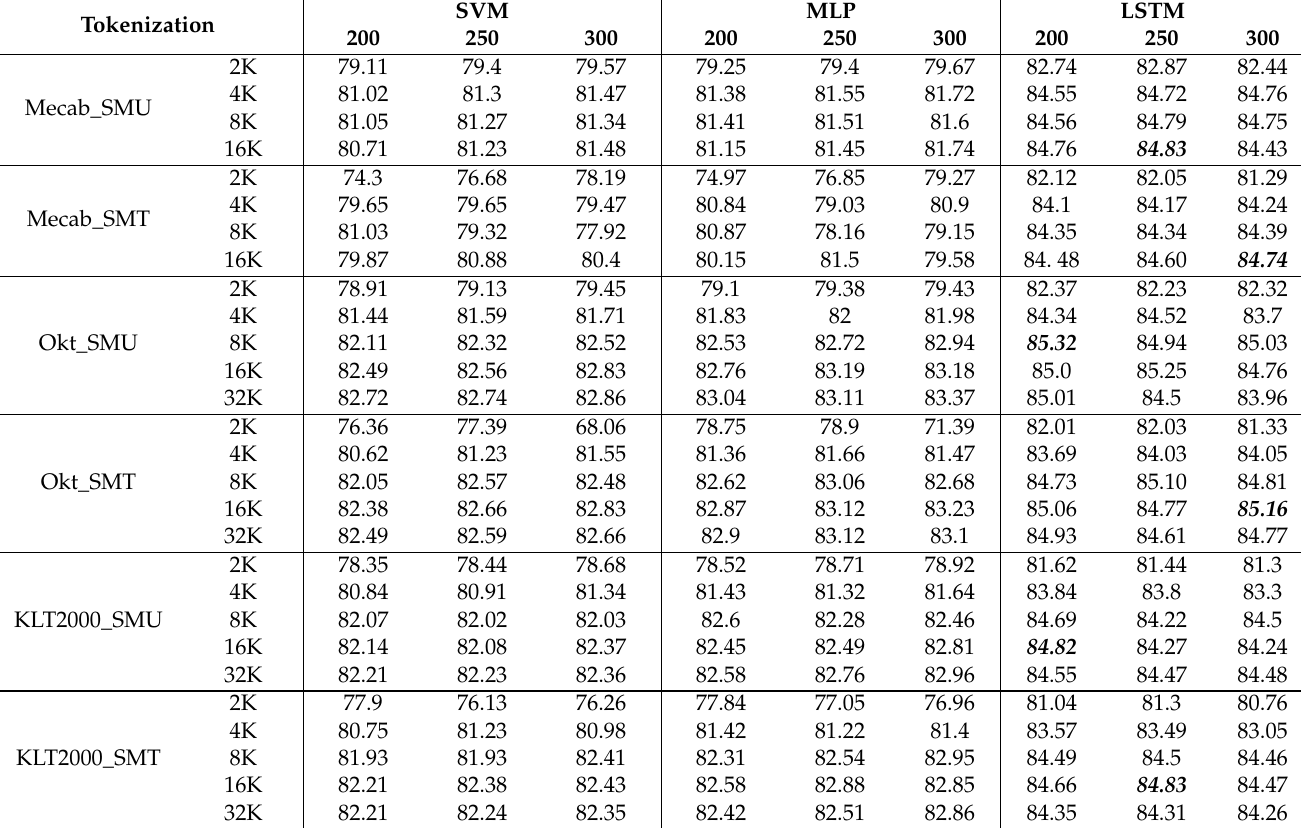
Table 5. Sentiment analysis accuracy with the sentence representation methods based on submorpheme tokenization.